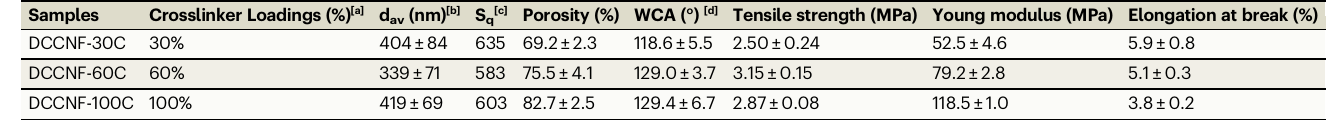
Table 1 | Physical and Mechanical Properties of different samples